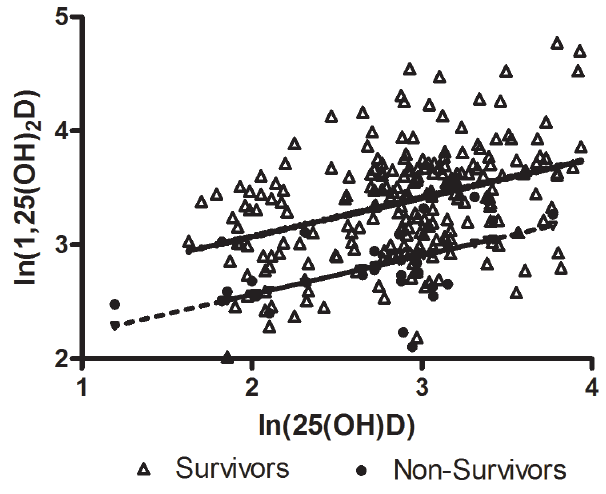
Figure 3. 1,25-dihydroxyvitamin D (1,25(OH) 2 D) as a function of 25-hydroxyvitamin D (25(OH)D). In both survivors and non- survivors, there was a significant increase in ln(1,25(OH) 2 D) for increases in ln(25(OH)D) (p , 0.01 and p = 0.02, respectively), such that ln(1,25(OH) 2 D) = 2.39 + 0.34(ln(25(OH)D)) for survivors, and 1.88 + 0.34(ln(25(OH)D)) for non-survivors. For the same level of 25(OH)D, 1,25(OH) 2 D would be lower in non-survivors compared to survivors (p , 0.01).